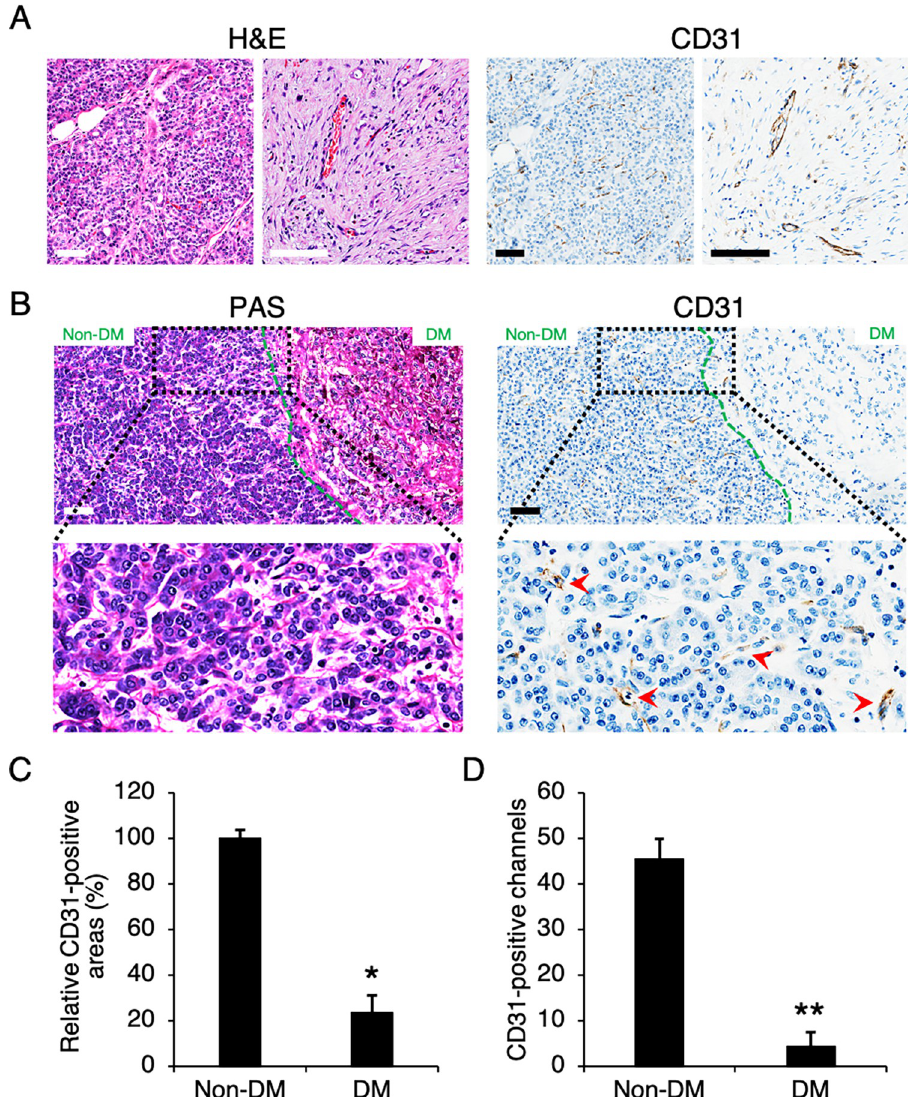
Fig 1. PDAC hypovascularity was associated with desmoplasia. (A) PDAC tissues were stained with H&E and immunostained for CD31. (B) PDAC tissues were stained with PAS and immunostained for CD31, and the border between non-desmoplastic (Non-DM) and desmoplastic (DM) regions were photographed and analyzed for (C) CD31-positive areas and (D) CD31-positive channels. Red arrows, CD31-positive cells. Scale bars, 200 μ m. Data presented ± S.D. � P value < 0.01, �� P value < 0.001 (n =